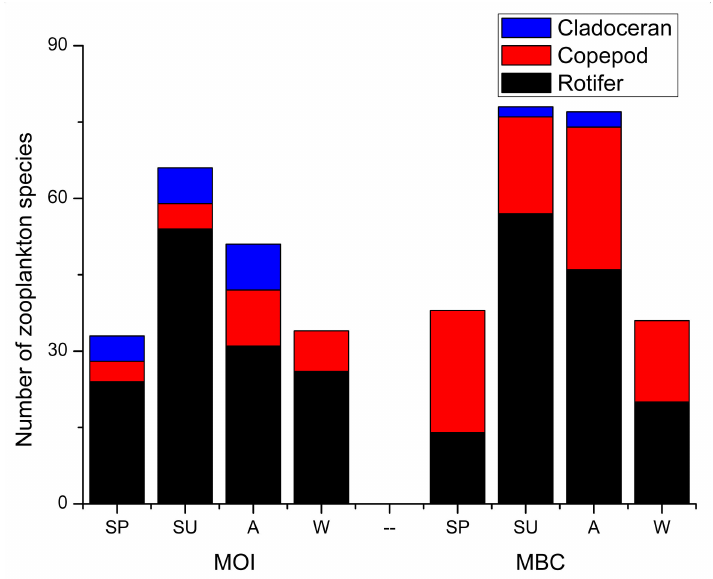
Figure 3. Three zooplankton species were detected by MOI and MBC. A: autumn; SP: spring; SU: summer; W: winter.